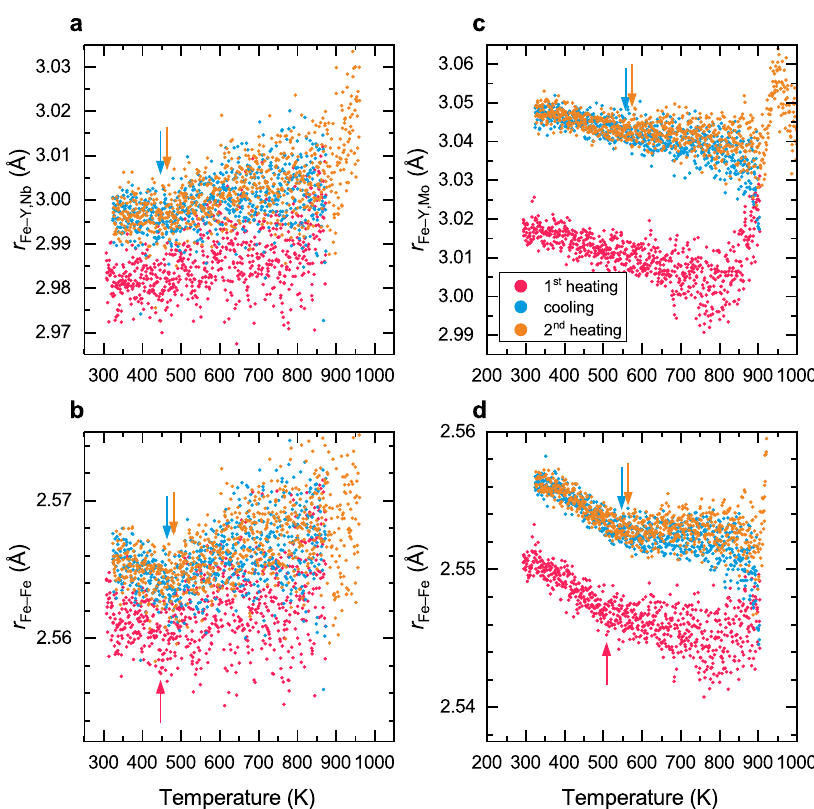
Fig. 6 Average atomic pair distance of the main constituents in the fi rst atomic shell of QNb and QMo. The fi rst atomic shell of QNb consists of a Fe – Y,Nb and b Fe – Fe in QNb. In QMo, the fi rst atomic shell is comprised of c Fe – Y,Mo and d Fe – Fe. The average Fe – Fe distance is reduced at the dilatometric transition temperature (marked with arrows) and a change in the contraction rate is clearly visible. This effect is stronger after the sample has been heated close to the glass transition temperature in the fi rst heating run. After heat treatment also the Fe – Y,Nb and Fe – Y,Mo atomic pairs show a change in the expansion rate at the dilatometric transition